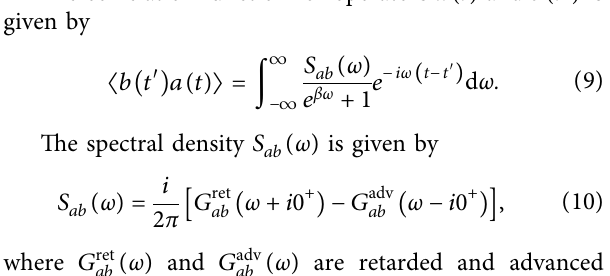
Figure 3: The behavior of superconducting order 〈 S x 〉 with in- creasing interaction strength β